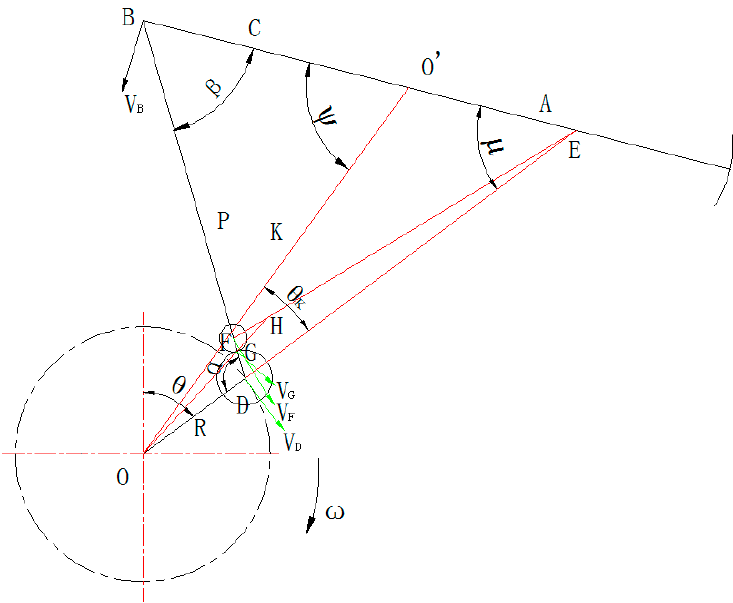
Figure 4. Schematic diagram of secondary balance motion analysis.